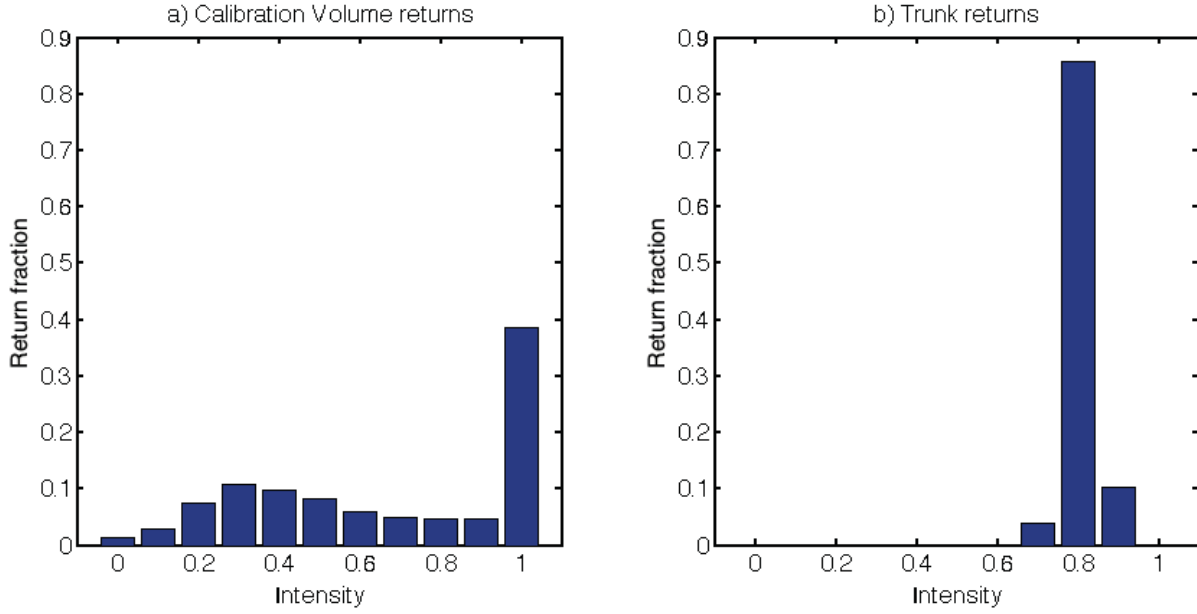
Figure 4. Intensity distributions of the TLS point cloud corresponding to: ( a ) points from inside calibration volumes, dominated by foliage and small branches, and ( b ) points from trunks at various distances from the scanner. These results show that no threshold on intensity can be used to separate leaf from wood in our scans. NB: Unlike in other studies, intensity was not normalized as a function of distance since the range of distances was similar between the two distributions and sufficiently narrow to assume that distance had no significant